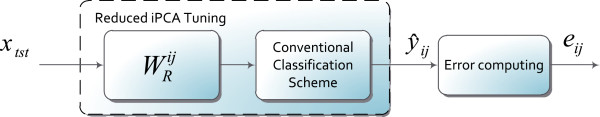
Blocks for system evaluation. The dotted line shown in the figure contains the test data classification tasks.